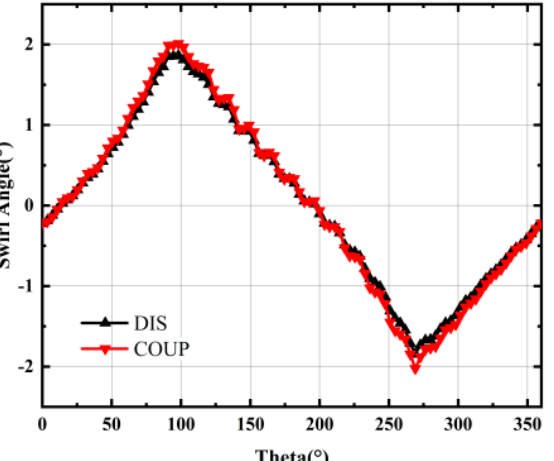
Figure 11. Time-averaged, circumferential distributions of swirl angle in the AIP section (at 95% spanwise).